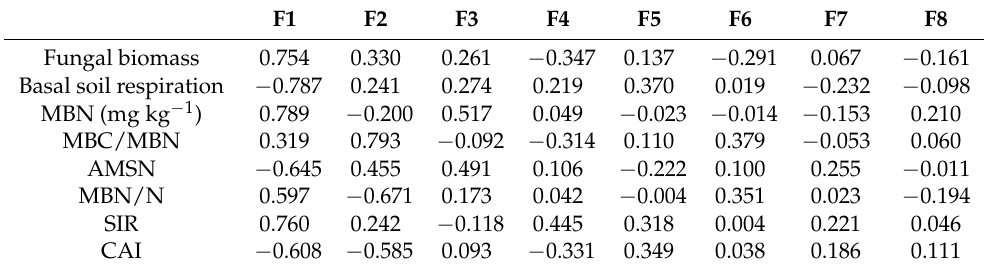
Table 9. Factor loading of the studied biological characteristics.